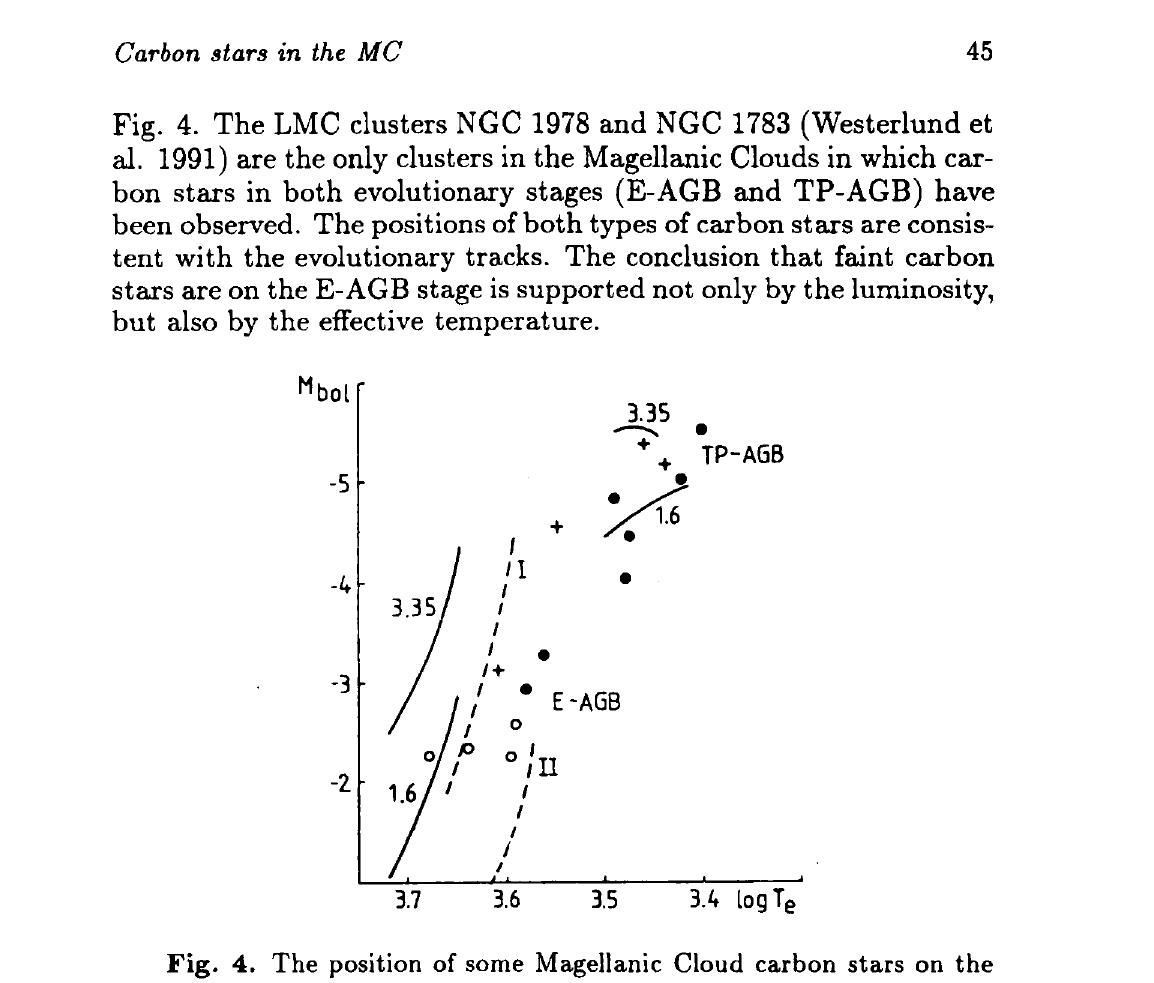
Fig. 4. The position of some Magellanic Cloud carbon stars on the HR diagram. The filled circles are for the carbon stars in the LMC clus- ter NGC 1978, the crosses are for the stars in the cluster NGC 1782 (Westerlund et al. 1991), and the open circles are for the four faintest SMC carbon stars from Westerlund et al. (1992). The evolutionary tracks I and II are from Lattanzio (1991) for the initial mass of 3 MQ : I is for Z= 0.001 and II is for Z= 0.02. The solid lines are from our calculations us- ing the analytical expressions by Iben and Renzini (1983) for the E-AGB stage and by Iben and Truran (1978) and Renzini and Voli (1981) for the TP-AGB stage. The tracks are labeled with initial stellar